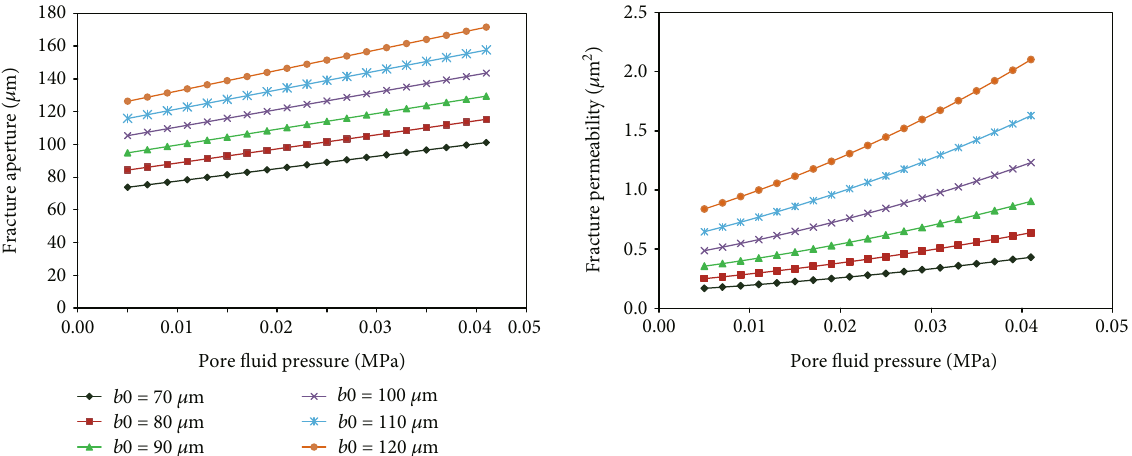
Figure 13: Fracture aperture and fracture permeability vs. pore- fl uid